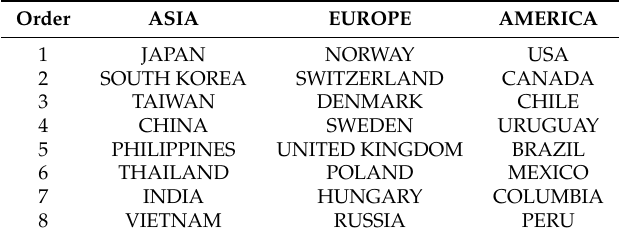
Table 10. Eight countries in Asia, 8 countries in Europe, and 8 countries in America. Order by 2017 GDP. Order